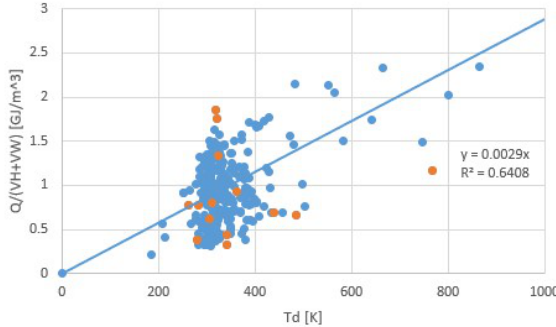
Figure 13. Heat storage densities Q / V (GJ/m 3 ) for salt hydrates, including the volume of process water in V for the same data as for Figure 12. Orange points are transitions with the lowest and highest transition entropies. Including process water in the storage density is fair for closed systems as in Figure 1 where process water is kept for rehydration. Consequently, the resulting heat storage density is smaller. In addition, the correlation heat between storage and temperature is more accurate, with r 2 = 0.64 compared to r 2 = 0.19 for Figure 12.